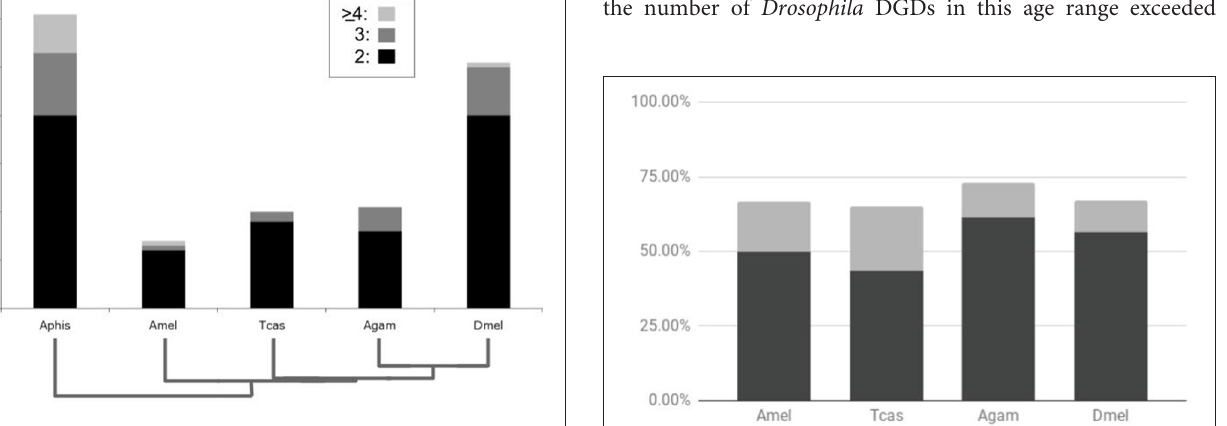
FIGURE 2 | Proportions of physical linkage among sampled lineage-specific gene duplicates. Results shown for Drosophila melanogaster (Dmel), Anopheles gambiae (Agam), Tribolium castaneum (Tcas), and Apis mellifera (Amel). Dark and light gray chart areas represent physical linkages within less than or exceeding 500kb,